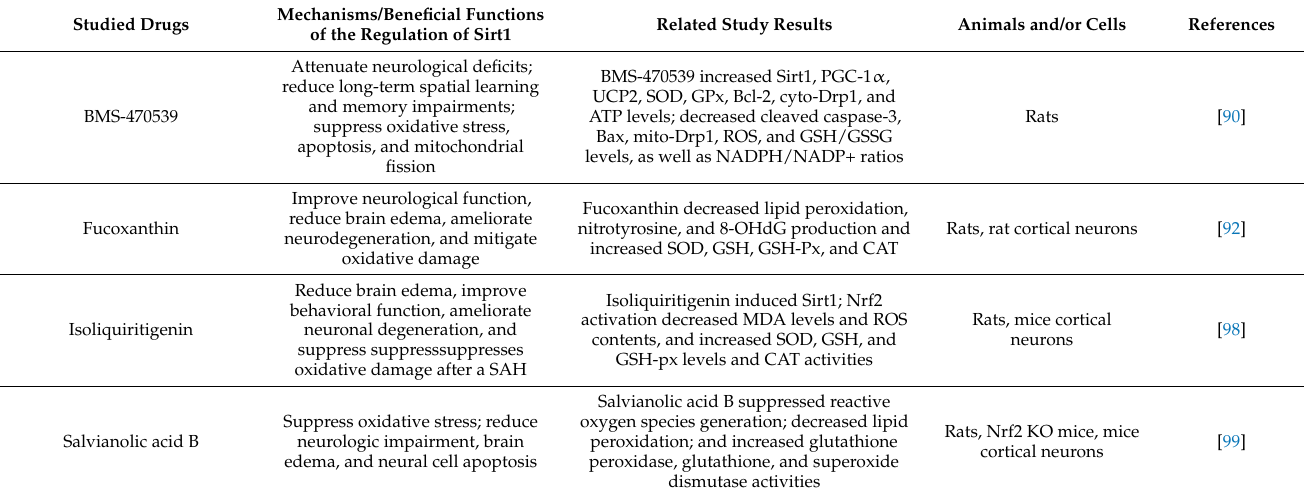
Table 2. Related studies exploring Sirt1-targeted antioxidant therapy for